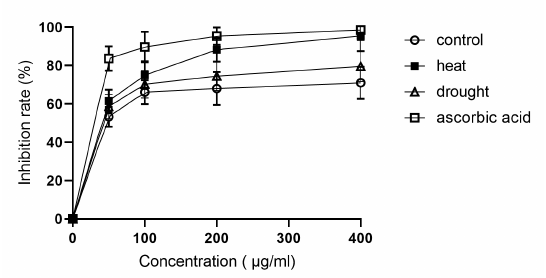
Figure 9. DPPH scavenging activity of methanolic extracts of E. sonchifolia with ascorbic acid. Data were represented as mean ± standard deviation of triplicate experiments.